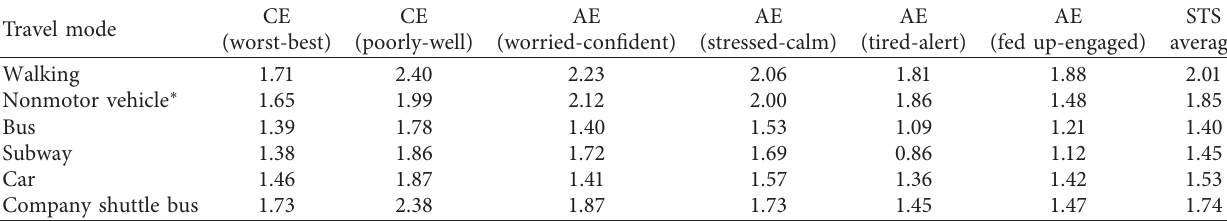
Table 4: Travel happiness for different travel modes.